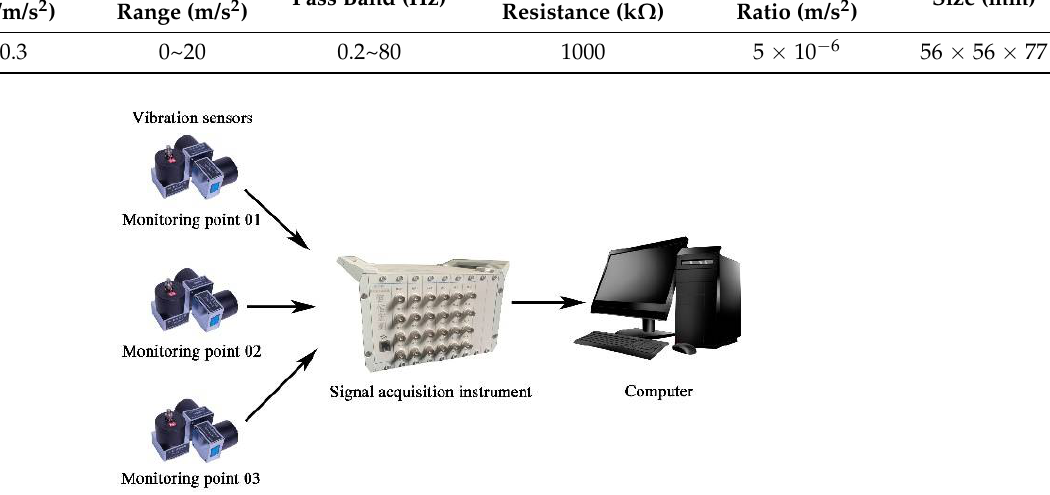
Figure 4. The principle of vibration monitoring.